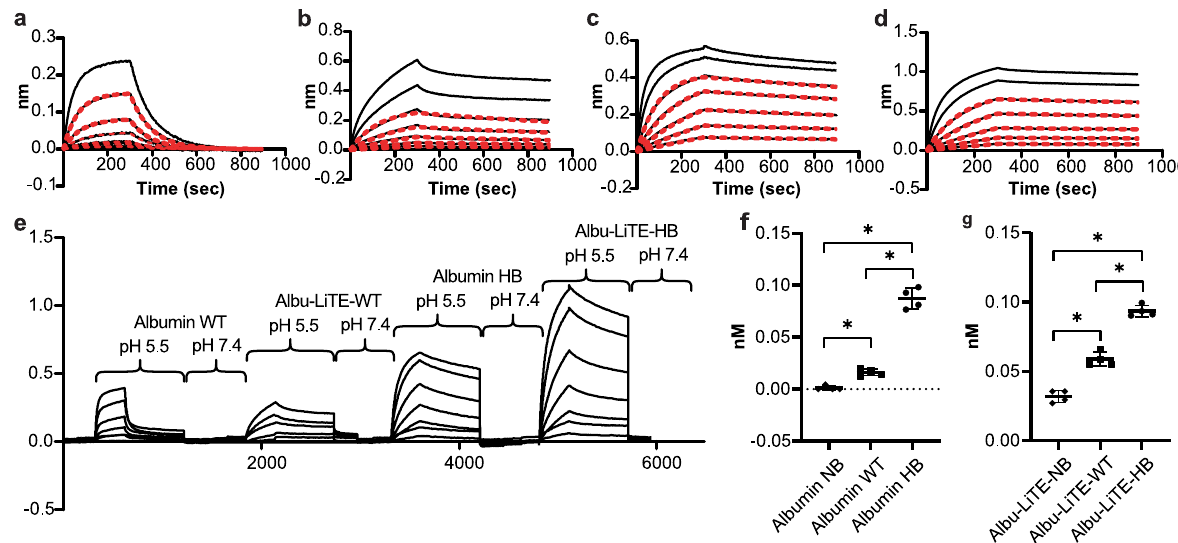
Fig. 2 Kinetic measurements and cellular recycling. Sensorgrams showing binding of serial dilutions of protein to immobilised human FcRn at pH 5.5. a Binding curves for wild type human serum albumin (Albumin WT). b Binding curves for Albu-LiTE-WT. c Binding curves for high-binding HSA (Albumin HB). d Binding curves for Albu-LiTE-HB. The sensorgrams were fi tted to a 1:1 model shown in red lines. e Bio-Layer Interferometry binding pro fi le showing binding between FcRn and albumin at pH 5.5 mimicking the pH of late endosomes and at physiological pH 7.4. f Variant-dependent detection of recombinant albumin in supernatant from human FcRn expressing cells incubated with null binding HSA variant (triangle), WT HSA (square) and HB HSA variant (circle). g Variant-dependent detection of Albu-LiTE fusion protein in supernatant from cells incubated with Albu-LiTE-NB construct (triangle), Albu-LiTE-WT construct (square) and Albu-LiTE-HB construct (circle). Statistical analysis was made in GraphPad prism v.8 using a Mann – Whitney U-test, * p < 0.05.